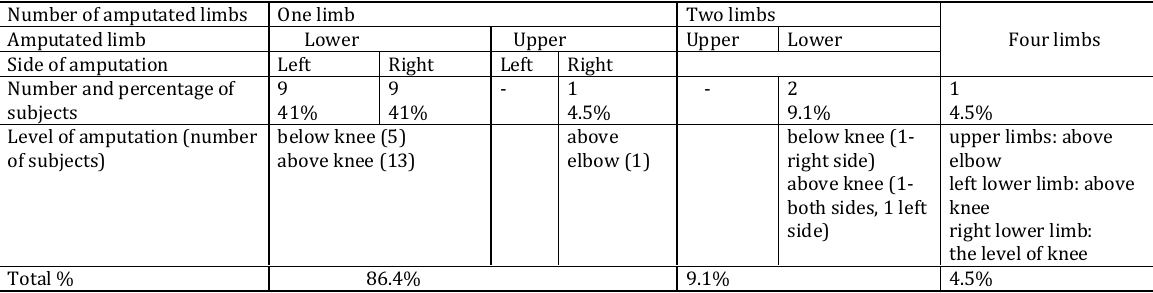
Table 2. Number of lost limbs and location of amputation (N = 22) Number of amputated